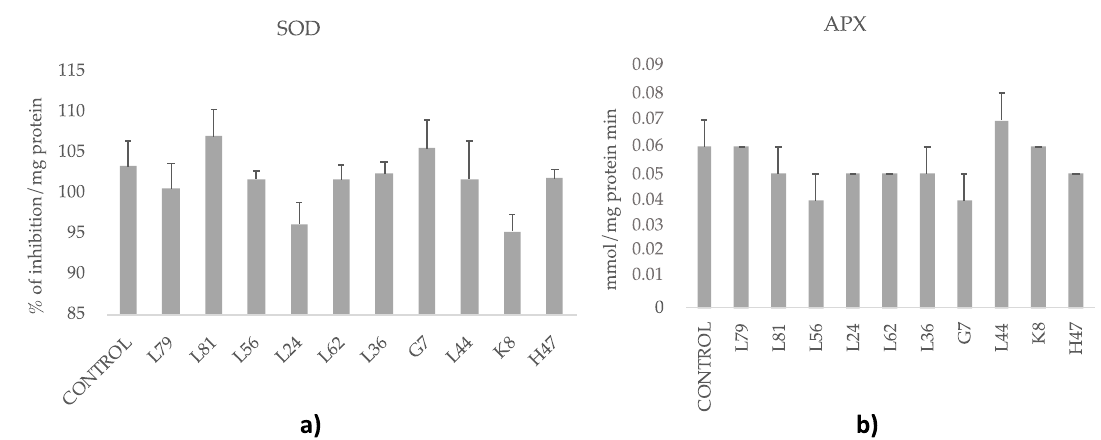
Figure 5. Enzyme activities related to oxidative stress. ( a ) Superoxide dismutase (SOD), ( b ) Ascorbate peroxidase (APX) activities measured in olive tree leaves treated with the ten strains. Enzymatic activities were calculated as mmol/mg protein min (for APX) and % of inhibition/mg protein (for SOD). For each treatment and parameter average value ± standard error value is presented ( n = 6). There are no significant differences according to the LSD test ( p < 0.05).